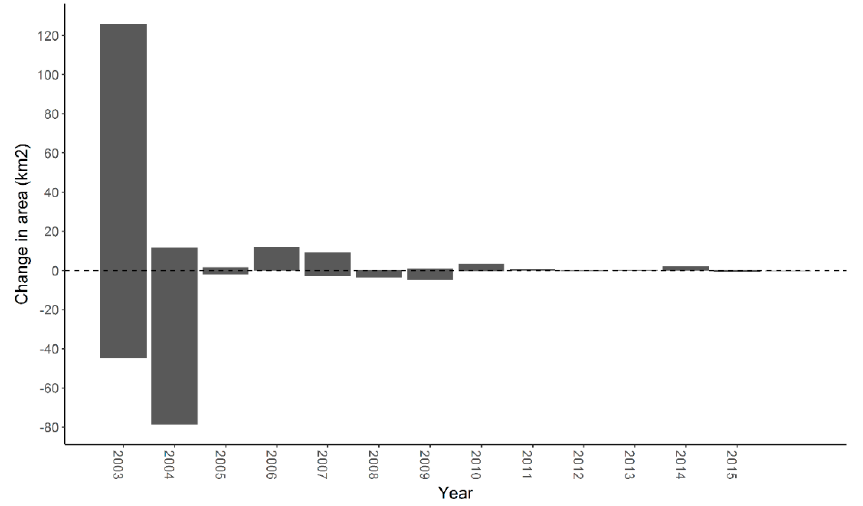
Figure 7. Amount of change in km 2 in Shimba Hills National Reserve.